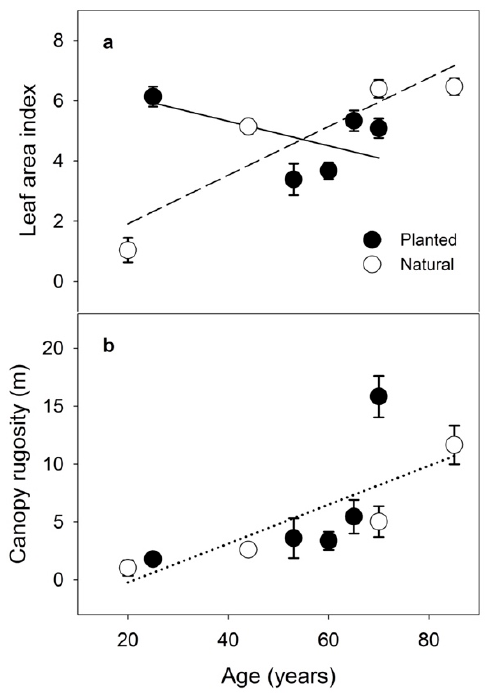
Figure 3. Mean leaf area index ( a ) and canopy rugosity ( b ) ( ± SE, n = 3) in relation to the age of planted and natural pine stands. Solid and dashed lines represent significant ( P < 0.05) relationships with age in the planted and natural pine chronosequences, respectively (a, r 2 = 0.26 and 0.79), and a single dotted line represents a significant ( P < 0.05) common relationship (b, r 2 = 0.47).